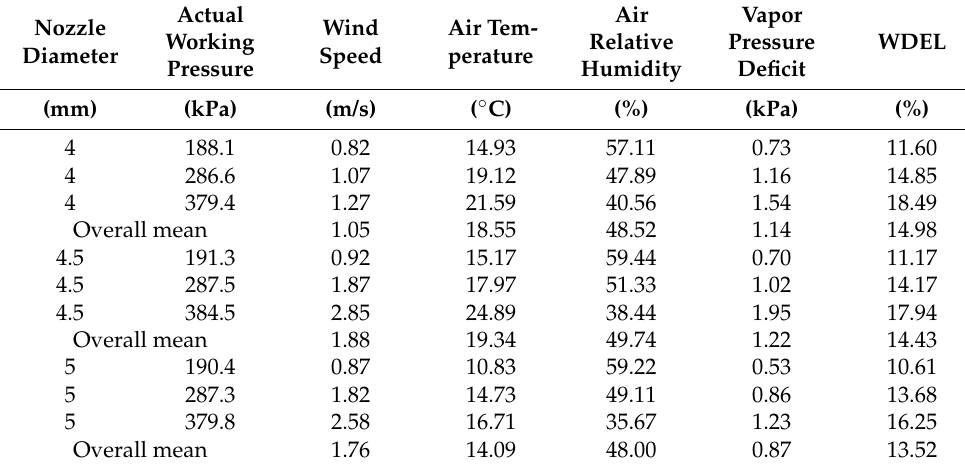
Table 3. WDEL averaged across a range of working pressures, nozzle diameters, and environmen- tal